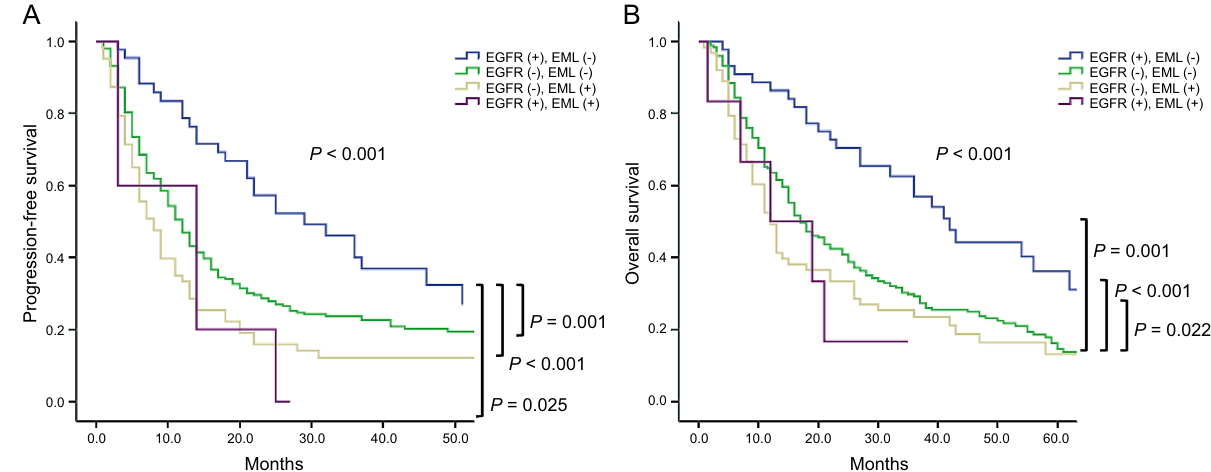
Figure 4. Median PFS according to EGFR and EML EGFR (−), EML (−) 11.0 (5.0–24.5); EGFR (+), EML (−) 25.0 (12.5–39.5); EGFR (−), EML (+) 8.0 (4.0–16.0); EGFR (+), EML (+) 8.5 (3.0–14.0) mo, respectively ( P < 0.001). Median OS was also as follows; EGFR (−), EML (−) 17.0 (9.0–35.5); EGFR (+), EML (−) 34.0 (21.0– 53.5); EGFR (−), EML (+) 12.0 (6.0–31.0); EGFR (+), EML (+) 15.5 (7.0–21.0) mo, respectively ( P < 0.001). Both median PFS and OS were highest in EGFR (+) and EML (−). EGFR, epidermal growth factor receptor; EML endobronchial metastatic lesion, mo months, OS overall survival, PFS progression-free survival.